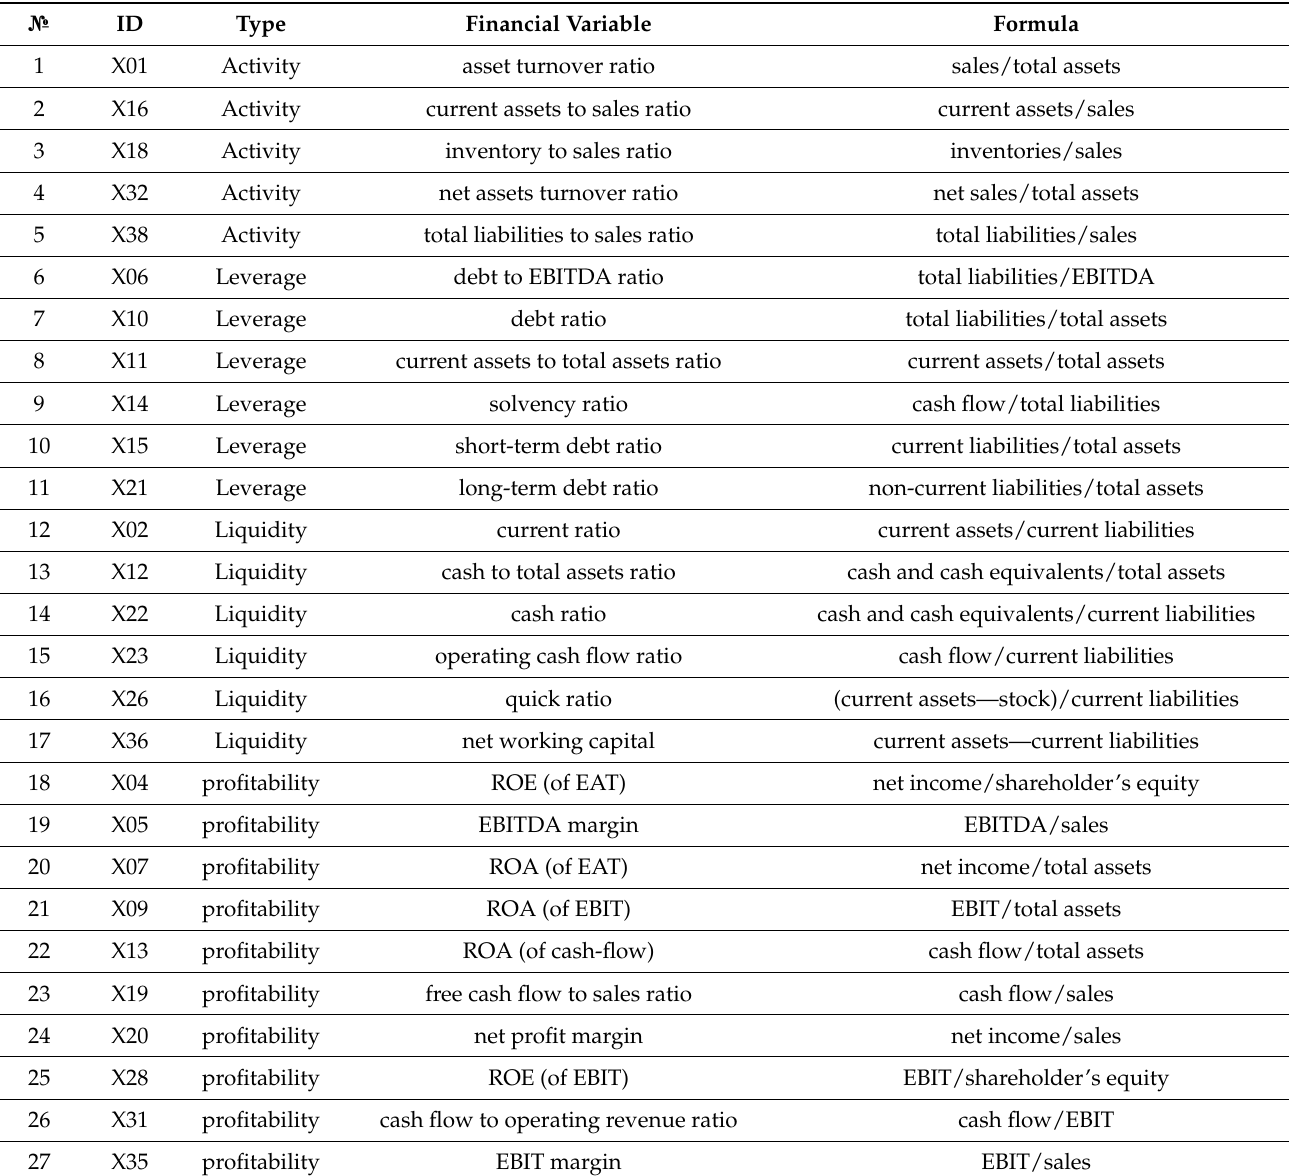
Table 4. Financial